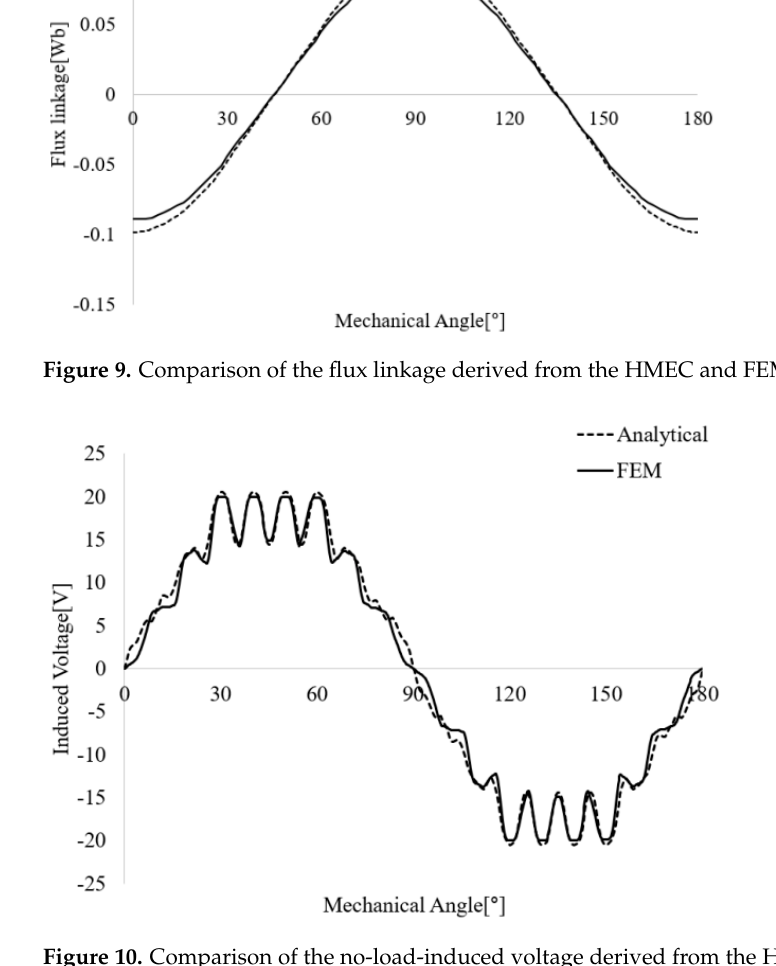
Figure 11. Comparison of the cogging torque derived from the HMEC and the FEM.